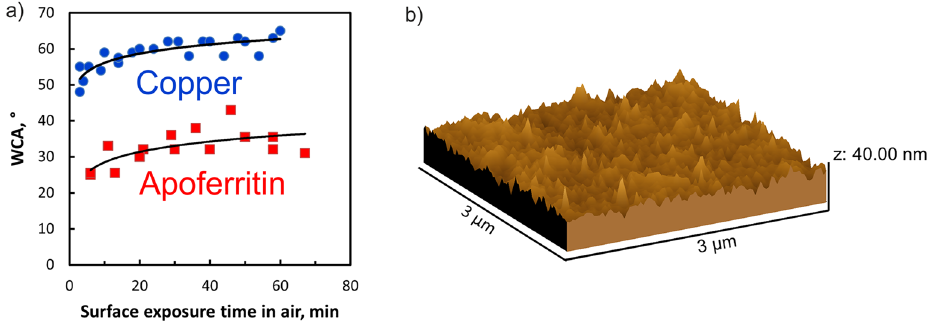
Figure 4. ( a ) Water contact angle as a function of exposure to air, measured on the copper stub surface (blue disks, three independent measurement series) and on an apoferritin droplet dried on copper (red squares, two independent measurement series); ( b ) surface topography measured by AFM. Created with WSXM (wsxm.eu/) and CorelDraw (www. corel draw.